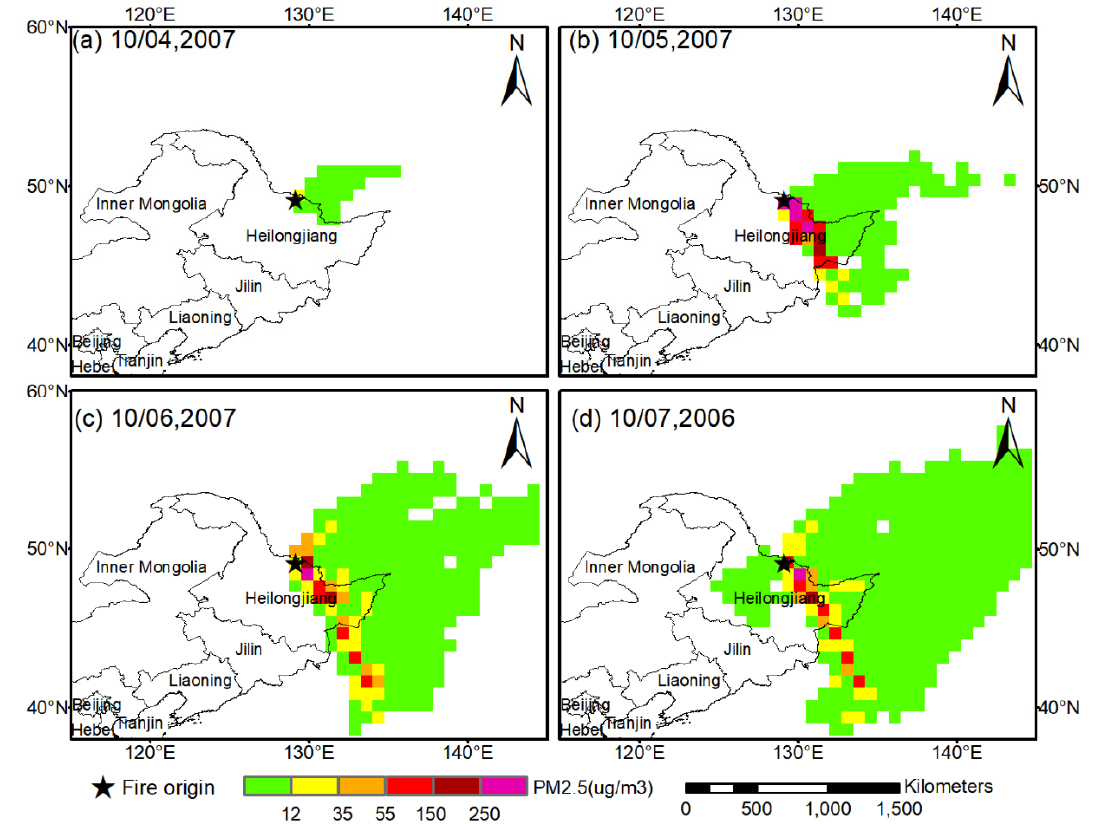
Figure6. SameasFigure3exceptfortheYichunfire. Panels( a – d Figure 6. Same as Figure 3 except for the Yichun fire. Panels ( a – d ) are 4, 5, 6, and 7 October 2007, respectively.